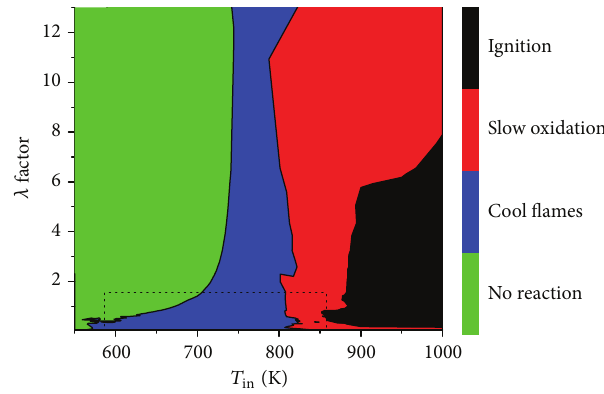
Figure 13: Predictions of main reactivity regions as a function of inlet temperature and lambda